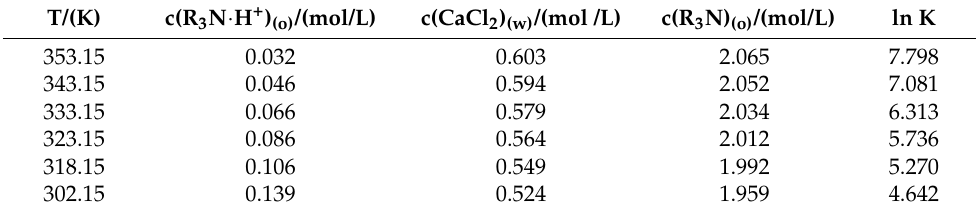
Table 5. Equilibrium concentrations and equilibrium constants at different temperatures.